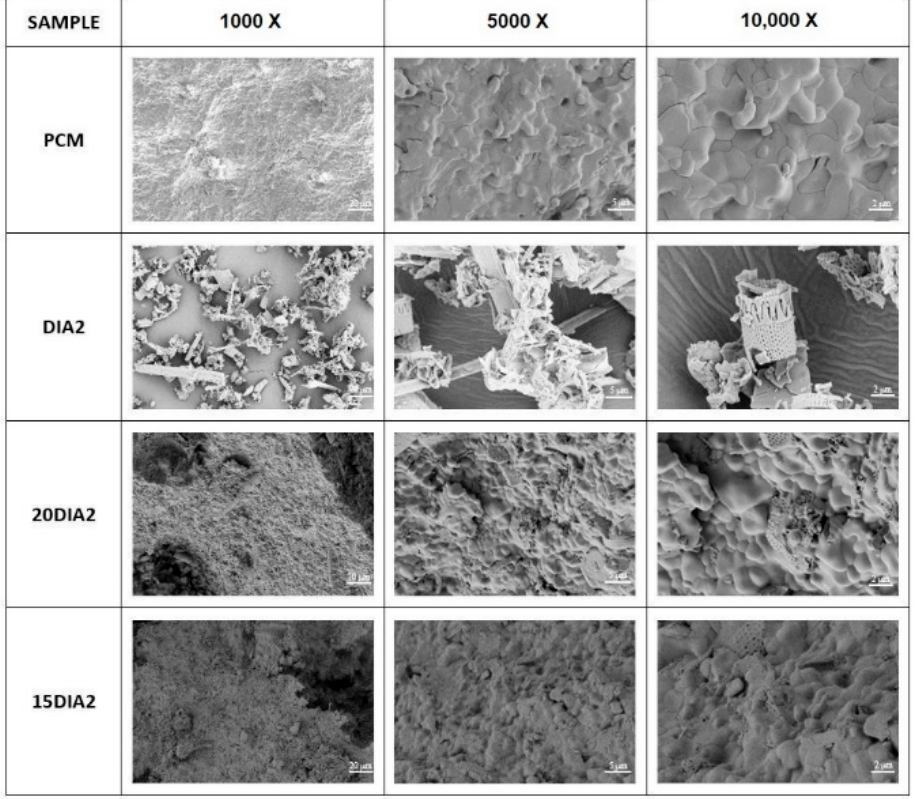
Figure 7. FESEM micrographs of the eutectic PCM, of the diatomite PM (DIA2) and the mEPCM samples with 80% (20DIA2) and 85% (15DIA2) of PCM.